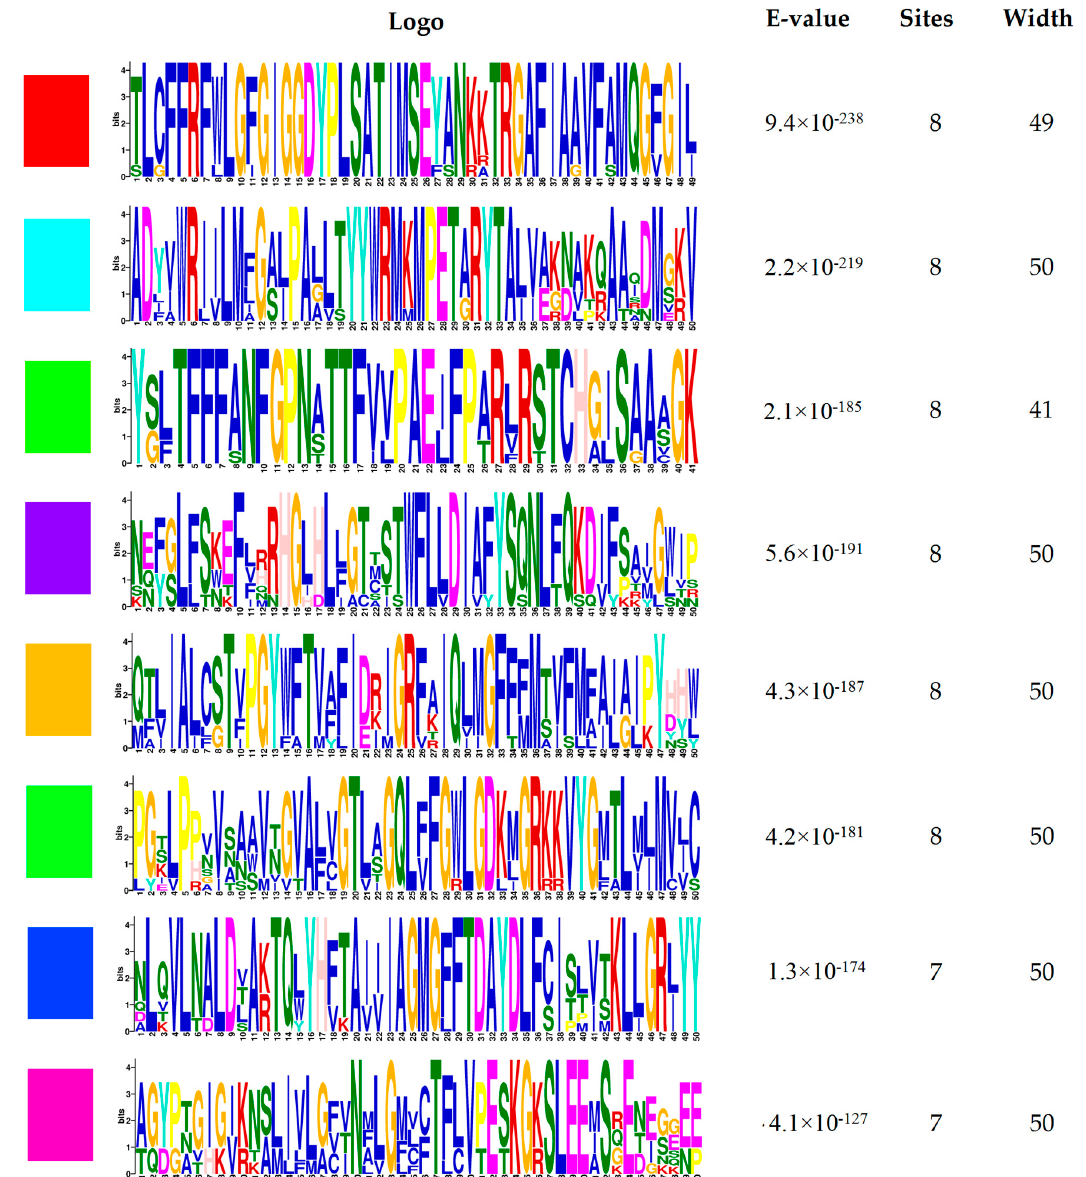
Figure 1. ( A ) Phylogenetic tree of the potato PHT1 gene protein. The potato PHT1 amino acid sequences were aligned using Clustal W. The phylogenetic tree was constructed using the neighbor-joining method, setting the bootstrap value to 1000. The numbers on the branch represent the bootstrap value. ( B ) Gene structure of the potato PHT1 gene family. The yellow boxes indicate the coding sequences. The discontinuous lines indicate the introns of these genes. The blue boxes indicate the upstream/downstream. ( C ) Domain prediction of the potato PHT1 proteins. The right side represents the motif composition associated with each StPHT1 protein. The motifs are displayed in different colored boxes. Motifs are sorted by E-value from small to large; different colors correspond to the motifs of the same color in Figure 1C.